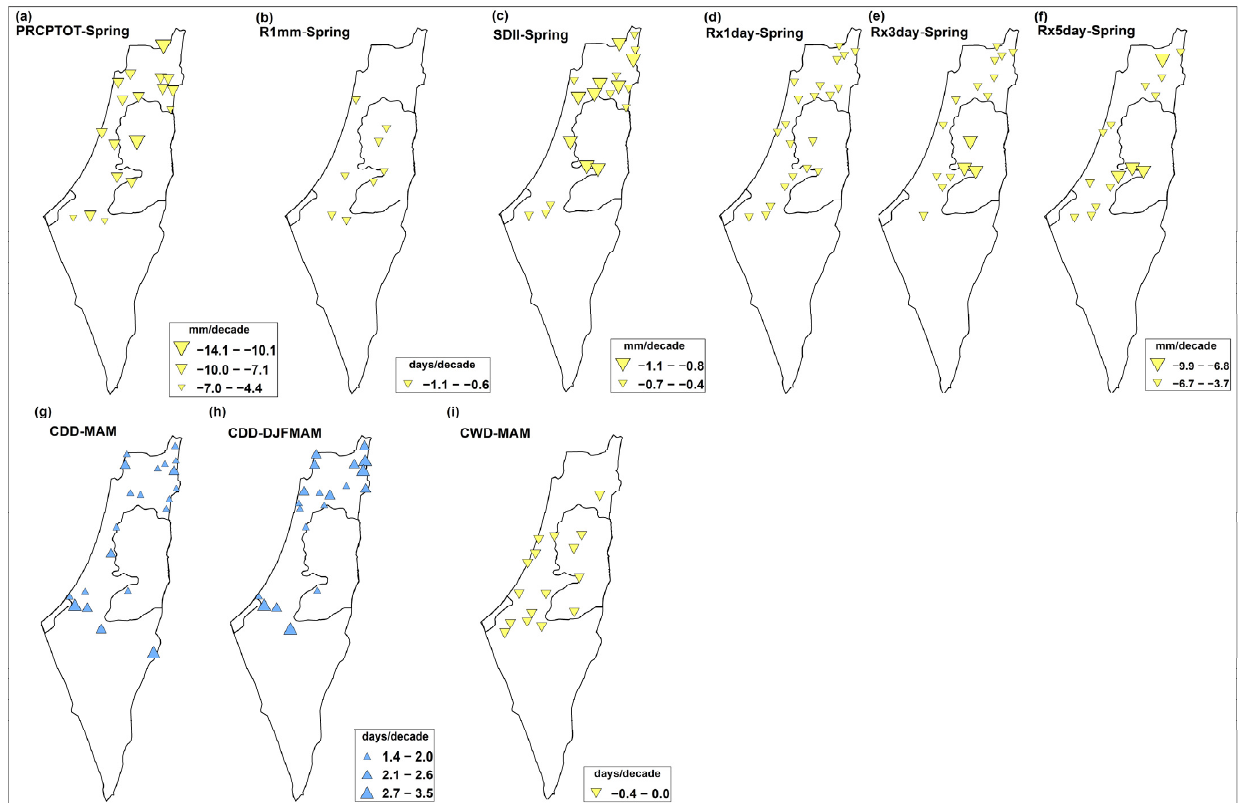
Figure 4. Spatial distribution of spring trends for some indices that exhibited notably decreasing (yellow triangles) or increasing (blue triangles) trends. Legends for RX1day, RX3day and RX5day, and for CDD-MAM and CDD-DJFMAM, are common, respectively.